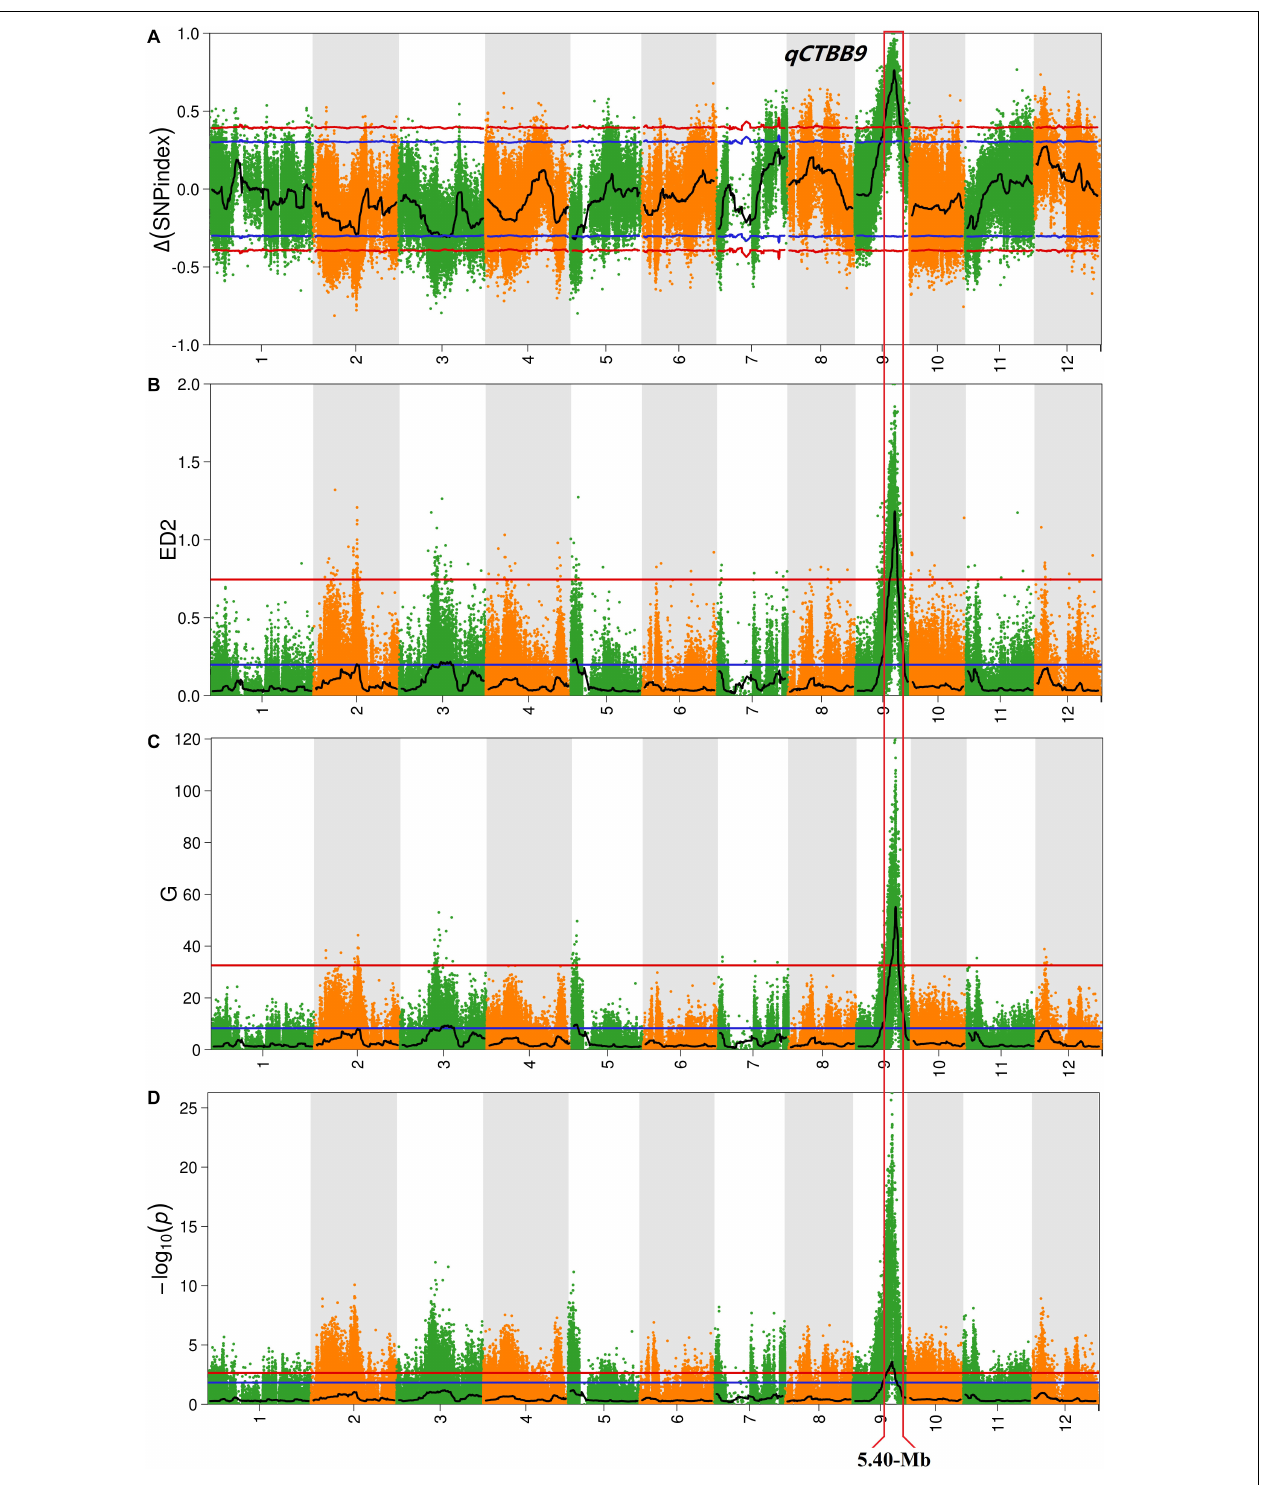
FIGURE 2 | Analysis of quantitative trait loci of cold tolerance at the bud-bursting stage based on QTL-Seq. (A) Manhattan plot shows the distribution of SNP-index and (cid:49) (SNP-index) on chromosomes. (B) The Manhattan plot shows the distribution of the square of the Euclidean distance on the chromosomes. (C) The Manhattan plot shows the distribution of G (cid:48) -Value on the chromosomes. (D) The Manhattan plot shows the distribution of –log 10 (P) value on the chromosomes based on Fisher exact test. The blue and red lines represent 95 and 99% confidence intervals, respectively.